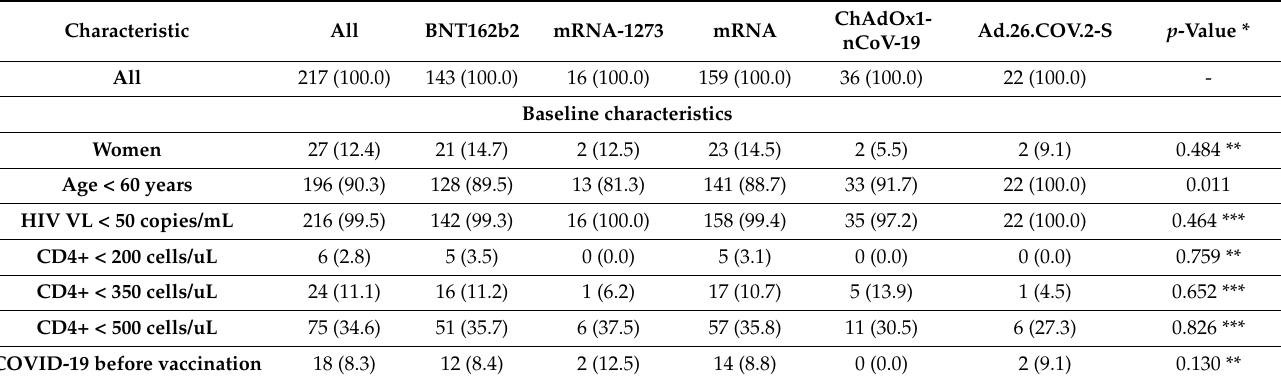
Table 1. Baseline characteristics of the HIV-positive individuals vaccinated against COVID-19 strati- fied by the type of first vaccination dose. Presented as number and column